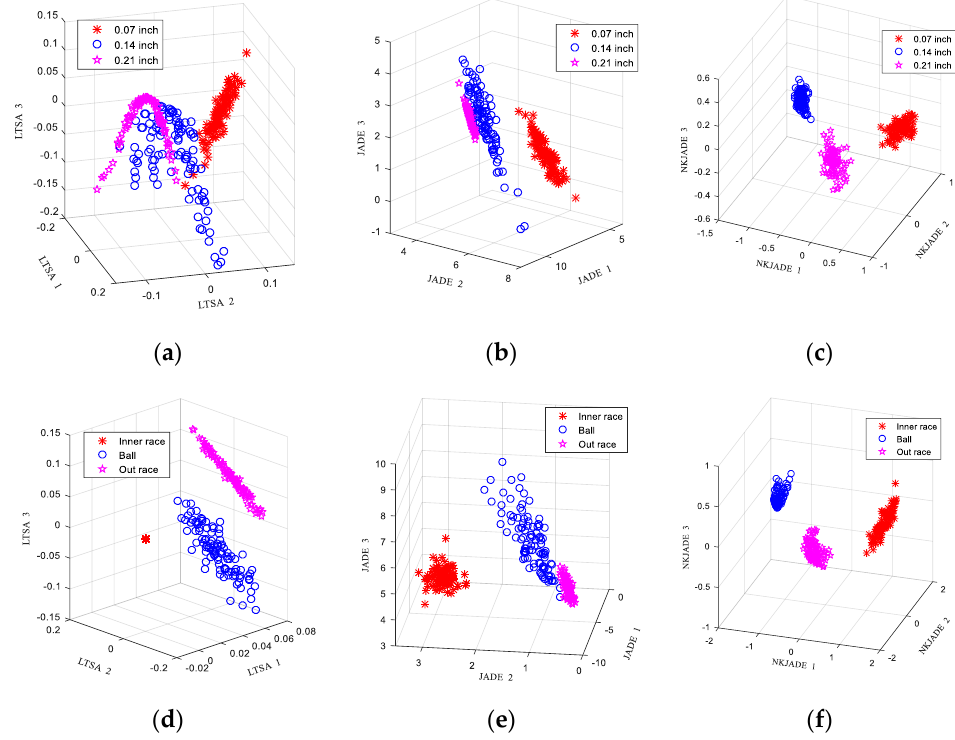
Figure 2. Scatter plots of faults. ( a ) EEMD-SVD-LTSA on dataset A; ( b ) EEMD-JADE on dataset A; ( c ) EEMD-NKJADE on dataset A; ( d ) EEMD-SVD-LTSA on dataset B; ( e ) EEMD-JADE on dataset B; ( f ) EEMD-NKJADE on dataset B.